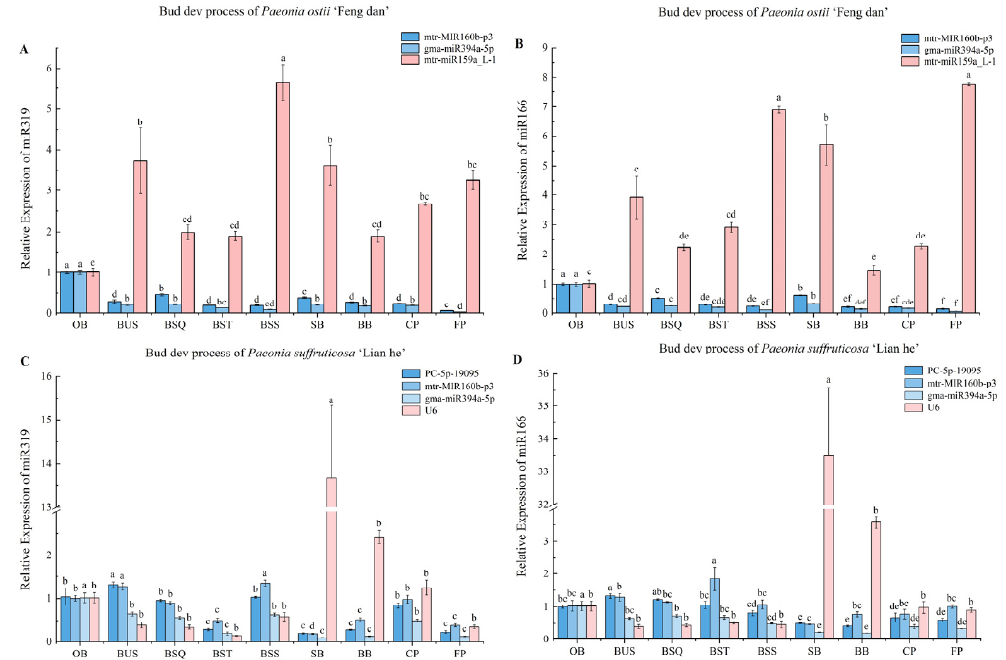
Figure 9. Performance evaluation of miR319 ( A , C ) and miR166 ( B , D ) expression standardization during the bud development process using reference miRNAs. OB: Overwintering bud; BUS: Budding stage; BSQ: Bud-squaring stage; BST: Bud-sticking stage; BSS: Bud-standing stage; SB: Small-bell stage; BB: Big-bell stage; CP: Circular peach stage; FP: Flat peach stage. The legend represents the internal reference used in calculating the relative expression amount. Different lowercase letters represent significant differences ( p < 0.05). Error bars are standard error of mean (SEM).